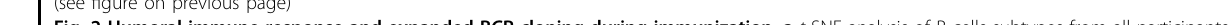
Fig. 2 Humoral immune response and expanded BCR cloning during immunization. a t -SNE analysis of B cells subtypes from all participants and timepoints. b Proportions of the B cell subtypes across participants and timepoints. c The pie plot showing the BCR clone differences across timepoints. The complexity and distribution of clonotypes differed among samples. d The bar plot showing the relative percentage of each isotype by each participant and timepoint. e The circus plots of the rearrangements of the BCR chains split by timepoints. The arc length of each segment corresponds to the relative frequency of each VDJ gene family. Within each plot, pairing VDJ gene segments are represented by colored ribbons. Ribbon width corresponds to frequency of the represented pairing. f The volcano plot showing the DEGs of expanded vs. non-expanded memory B cells and plasma cells at day 14 and day 28 post-vaccination. Genes with greatest fold changes and signi fi cant P values were annotated in the plot. g The enriched GO terms of the DEGs in expanded B cells upregulated 28 days